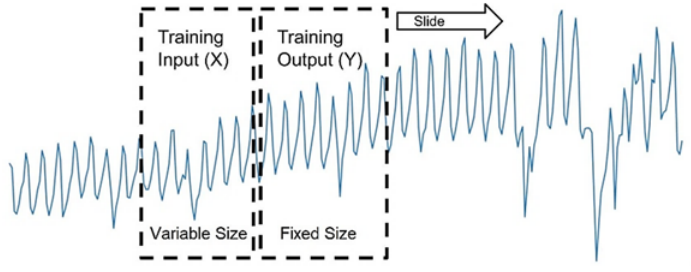
Figure 13 . Time Series Split for Model Validation.